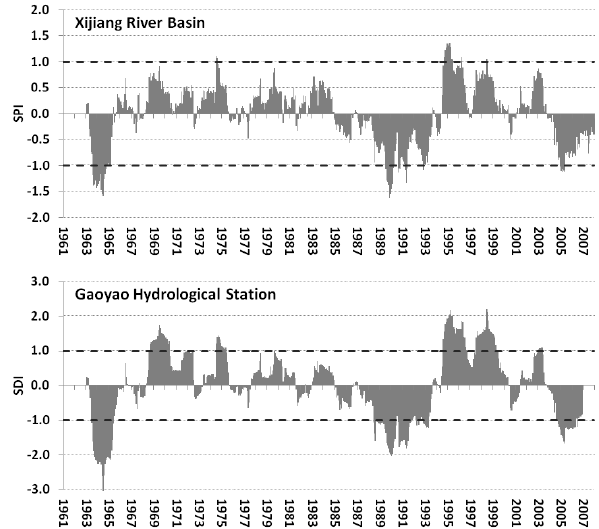
Fig. 5. SPI-24 of the Xijiang River basin (upper panel) and the SDI- 24 of Gaoyao hydrological station (lower